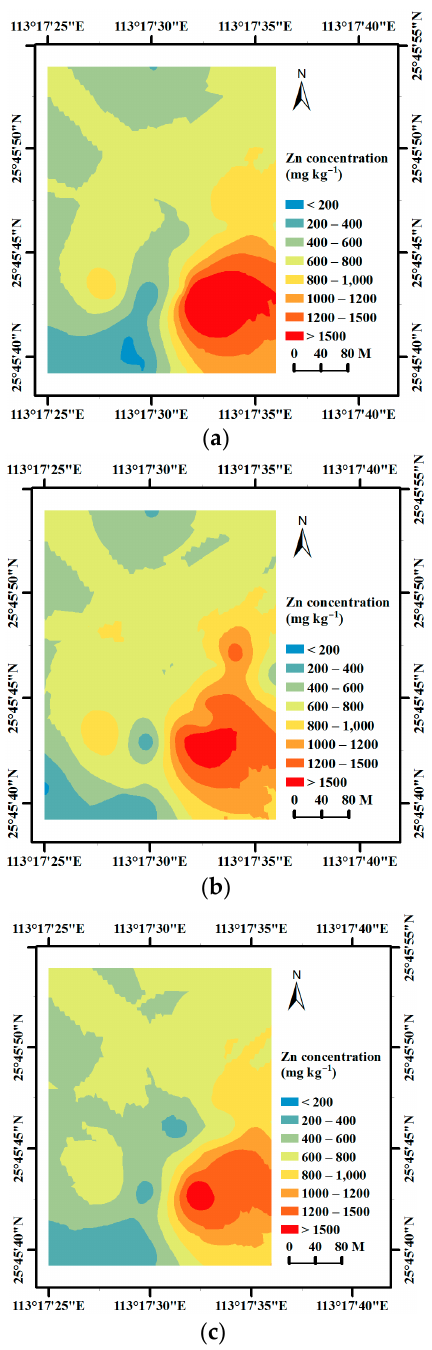
Figure 8. The filled contours maps of soil Zn: ( a ) generated by ordinary kriging based on measured data; ( b ) generated by ordinary kriging based on the predicted Zn concentration derived from the unclassified soil spectra; and ( c ) generated by ordinary kriging based on the predicted Zn concentration derived from the classified soil spectral